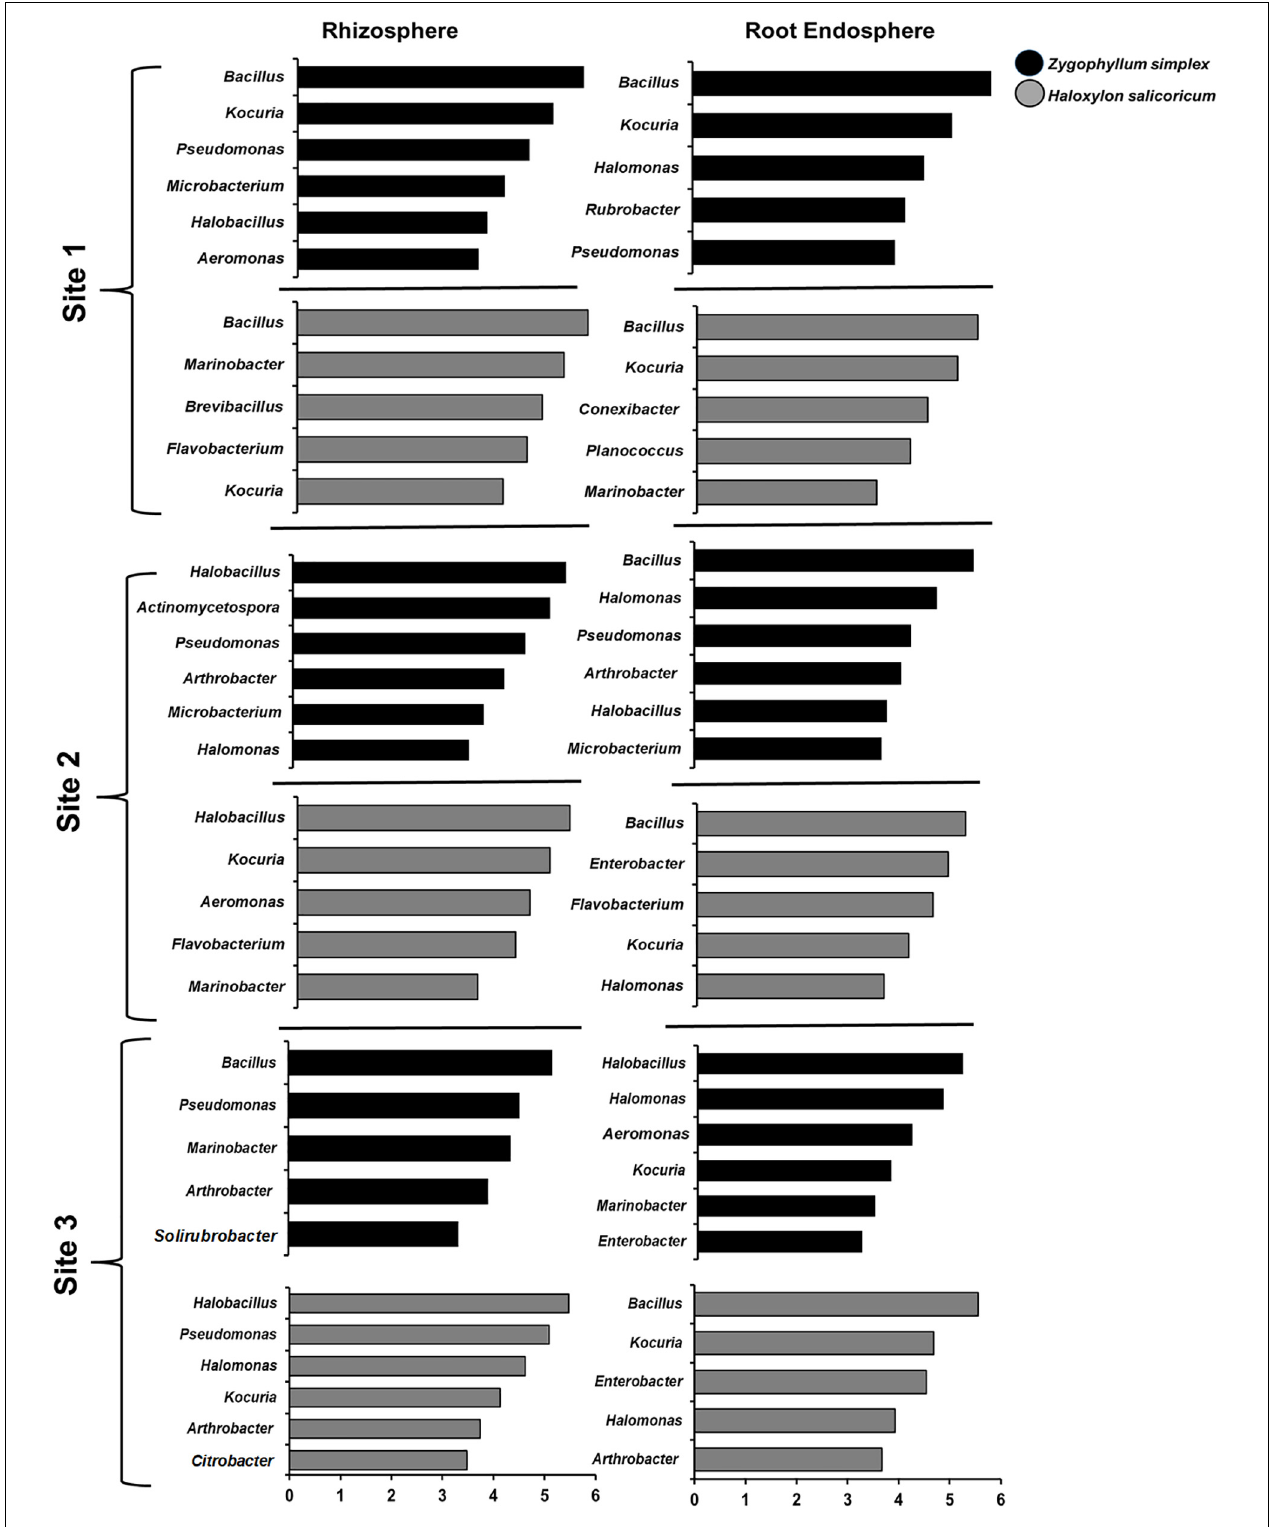
FIGURE 6 | The results of LEfSe analysis showed the identified bacterial genera that were significantly abundant in the rhizosphere and root endosphere of halophytes. Variations in the bacterial genera detected across the rhizosphere and the root endosphere of Zygophyllum and Haloxylon from three sampling sites. Bacterial genera with the LDA score of more than 3.5 are